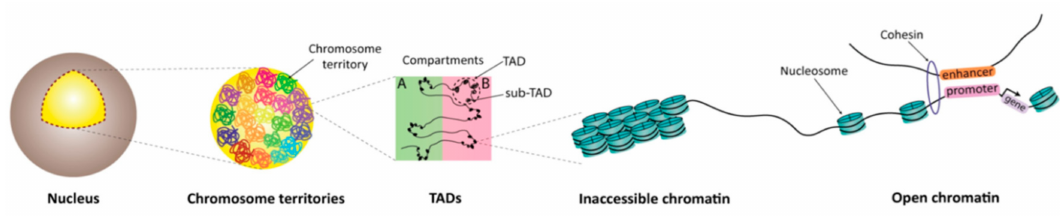
Figure 3. Genome organization. The mammalian genome possesses di ff erent levels of organization. From a large scale to a fine scale, chromosome territories (each in a di ff erent color), compartments A (active chromatin) and B (repressed chromatin), topologically associated domains (TADs), and nucleosomes of two homologous alleles are shown (from left to right). Middle: Compartments A and B are indicated by a green and red background, respectively. Homologous alleles are regulated